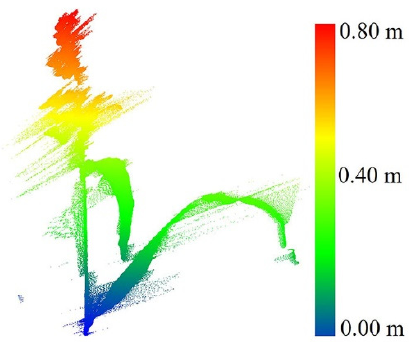
Figure 2. Original single sorghum plant collected in the greenhouse.